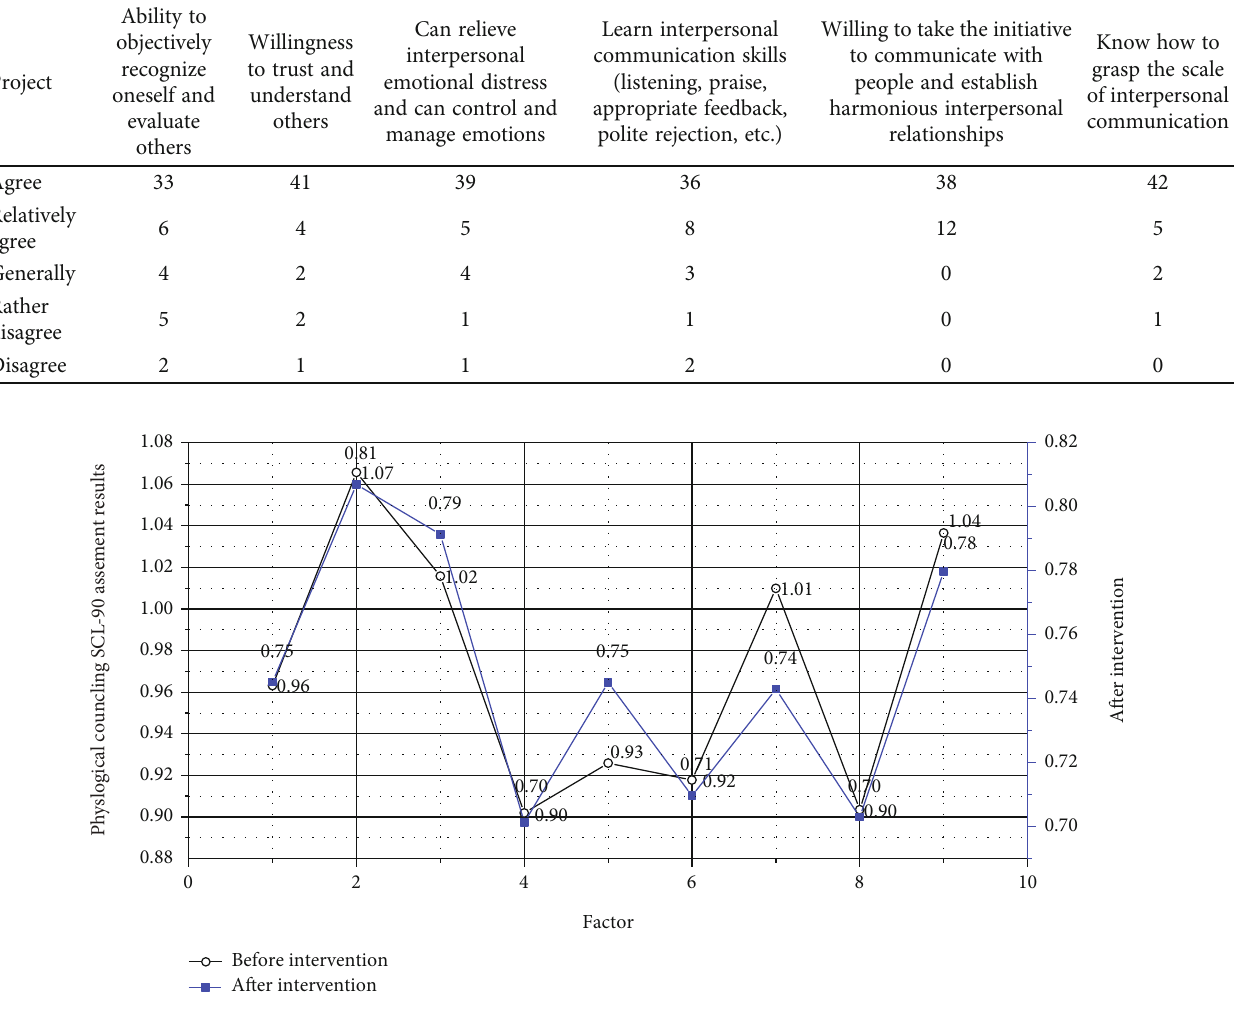
Figure 2: Comparison of SCL-90 assessment results before and after psychological counseling.